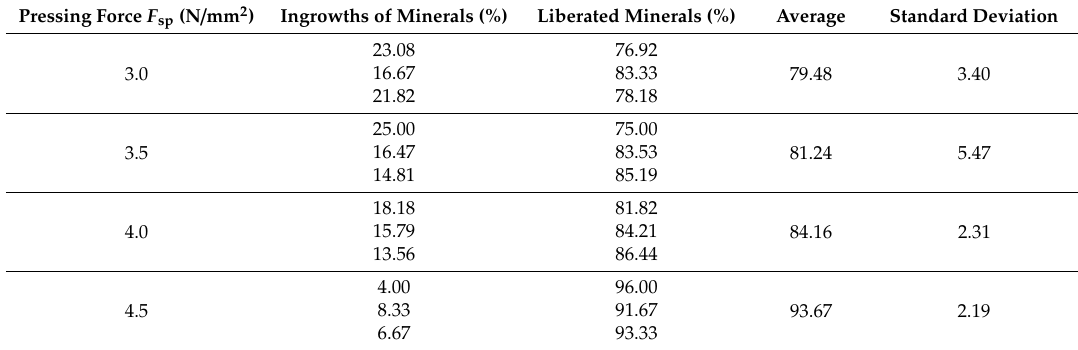
Table 5. Intergrowths and fully liberated copper sulphide minerals for HRC crushing products—results of all assays.